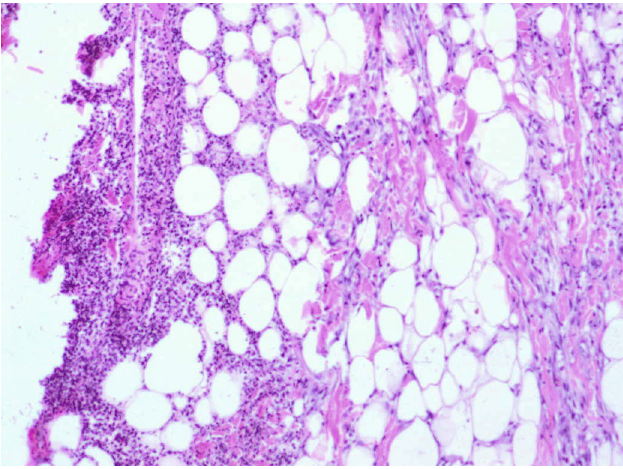
Figure 3. Day 7, D1-1% Sepropol-epithelium defect with necrosis, inflammatory infiltration with granulocytes (enlargement 150×, HE).